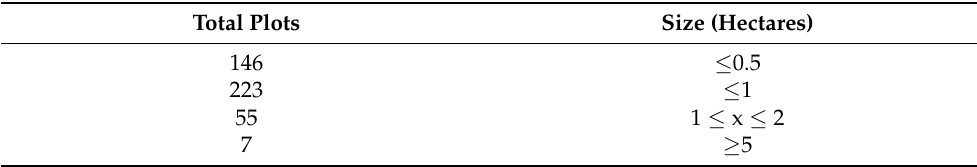
Table 1. Typology of the study enclosures according to their surface